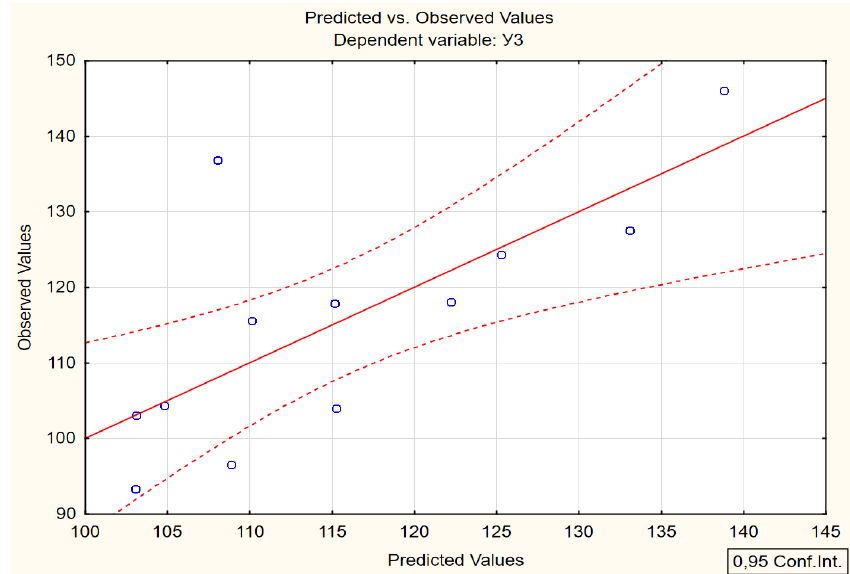
Figure 6. Observed and predicted values for the dependent variable (Y3).